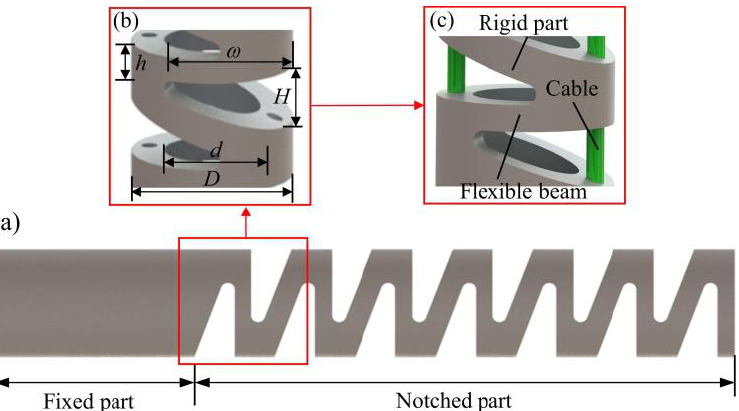
Figure 1. The illustration of the structure: ( a ) 3D model of the NCR, ( b ) structural parameters of a single notch, ( c )different parts of joint.